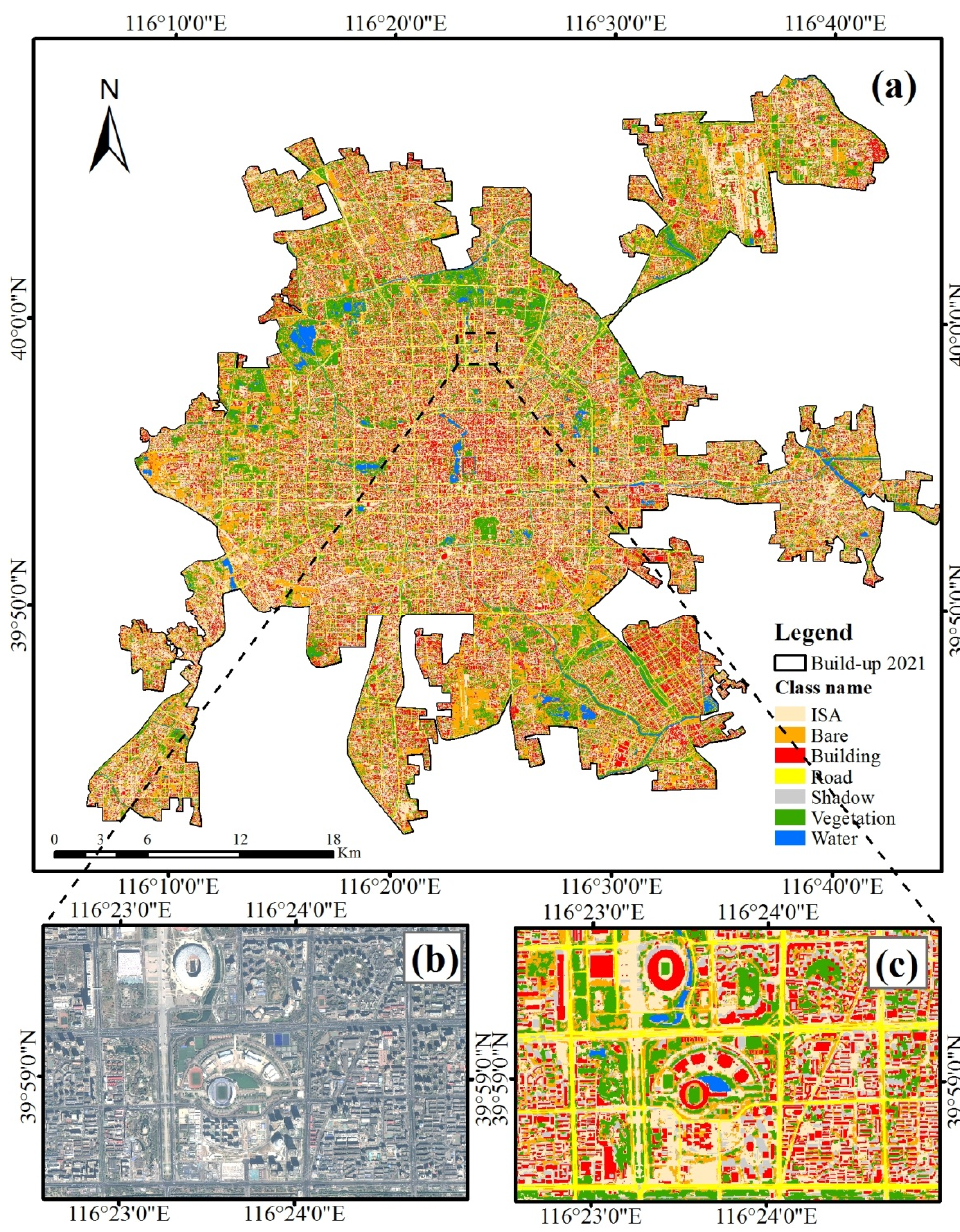
Figure 7. (a) Land-cover mapping of the BUA in Beijing in 2021; (b) detailed comparison of GaoFen- Figure 7. ( a ) Land-cover mapping of the BUA in Beijing in 2021; ( b ) detailed comparison of GaoFen-1 1 imagery; and (c) classification results. imagery; and ( c ) classification